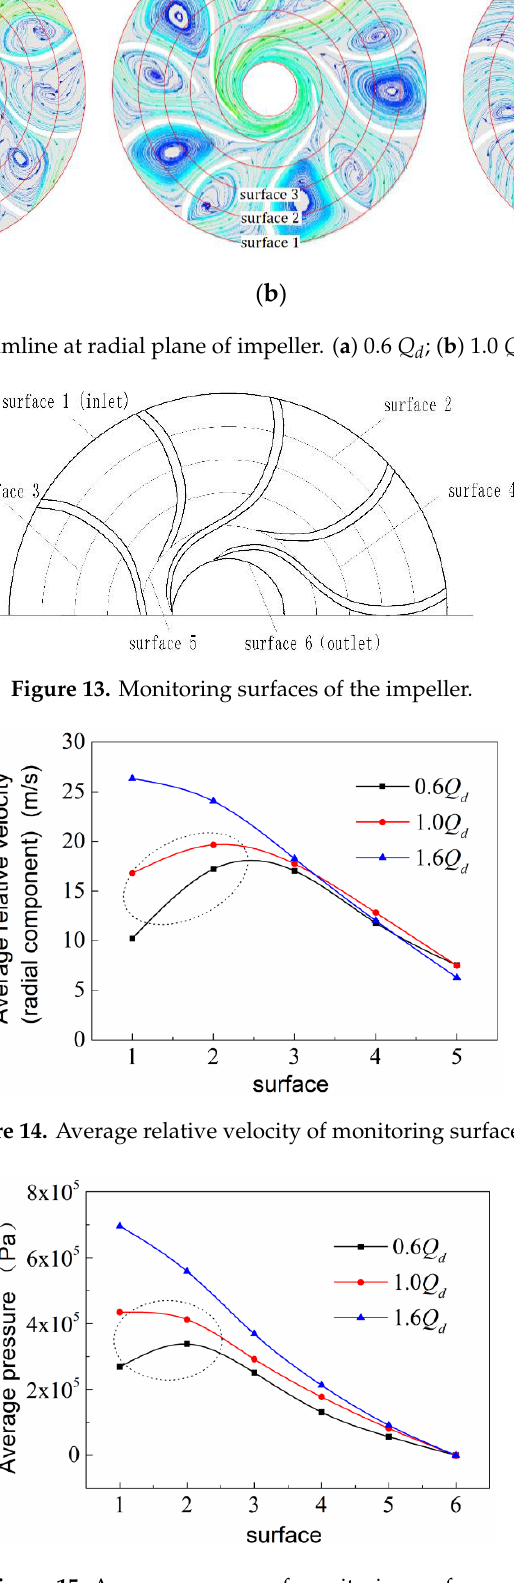
Figure 16. Zones of the impeller. For any zone i , when the boundary condition with a pressure inlet and flow rate outlet are given, while rotating speed is fixed, the theoretical power (fluid power) and actual power (shaft power of PAT) can be obtained by numerical simulation. The theoretical power can be described as ' ( , 1)